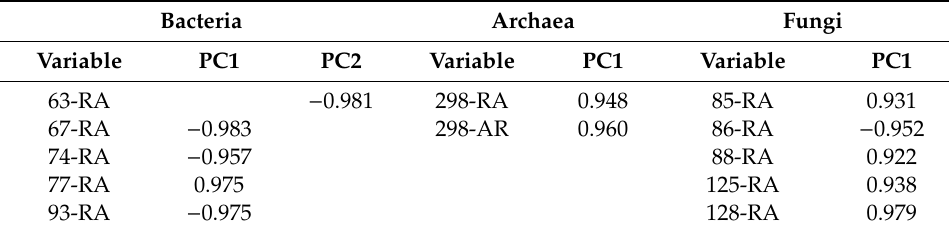
Table 5. Loadings for the most significant variable along PC1 and PC2 resulting from principal components analysis for bacteria, archaea and fungi ( R ≥ 0.9). RA, relative abundance and AR, area of peaks. 63–361, size of peaks in base pairs.